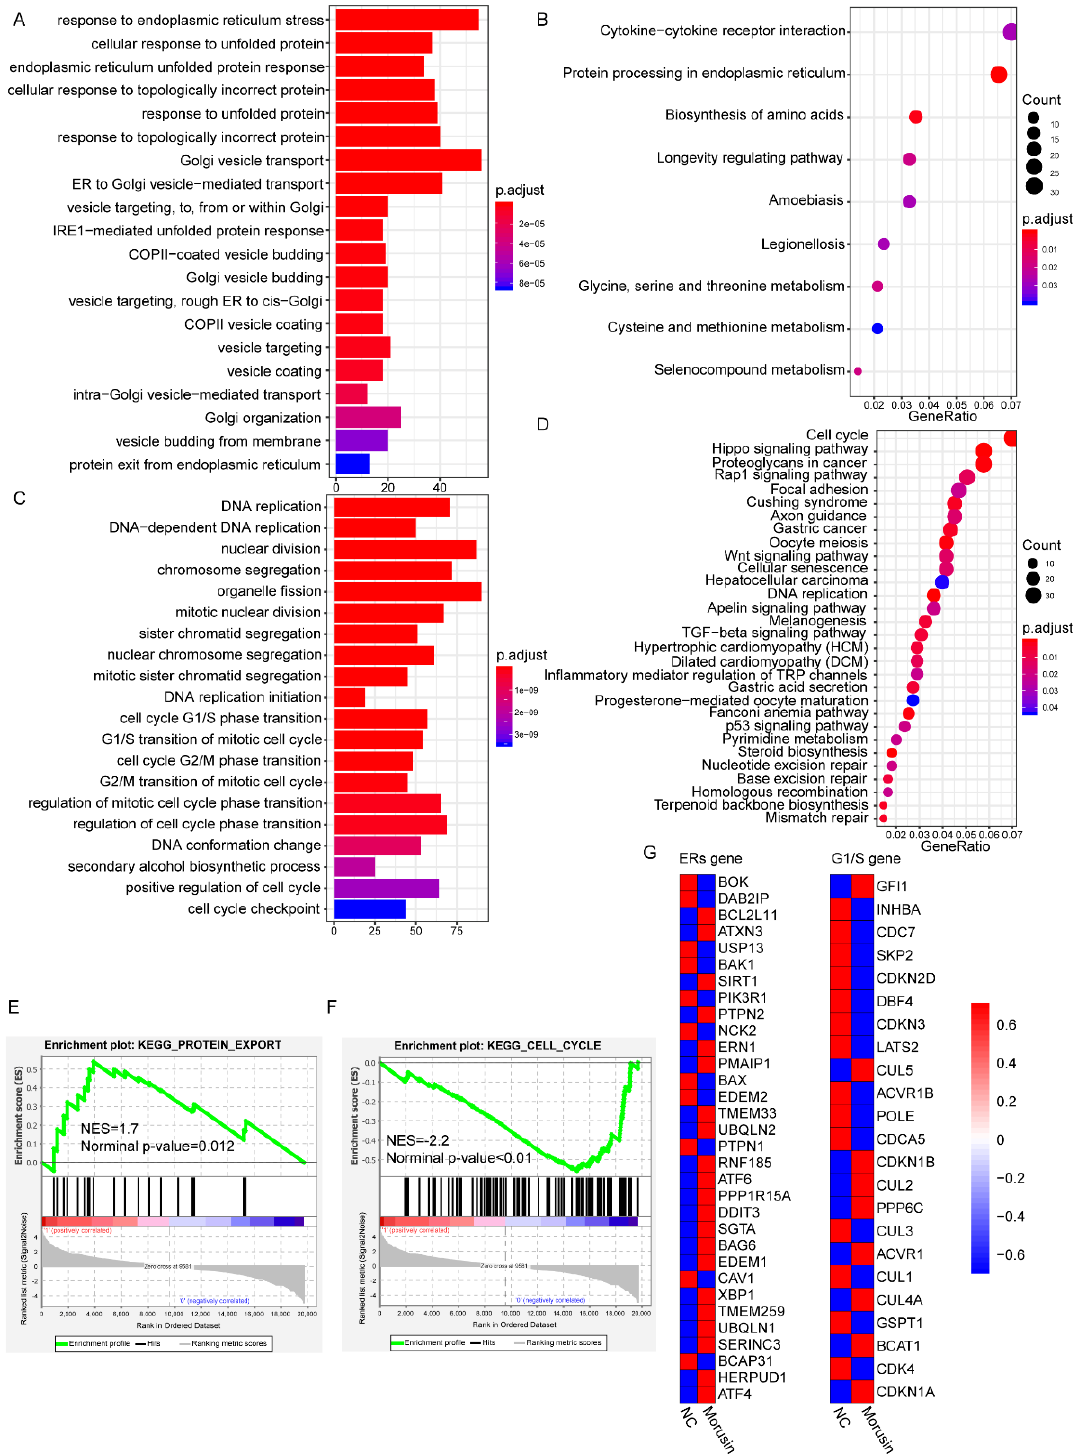
Figure 5. RNA-seq analysis of morusin treated U87 cells. ( A , B ) Gene Ontology (GO) and Kyoto Encyclopedia of Genes and Genomes (KEGG) pathway enrichment analysis of up-regulated mRNA after morusin treatment. ( C , D ) GO and KEGG pathway enrichment analysis of down-regulated mRNA. ( E , F ) GSEA-based KEGG enrichment plots of representative gene sets from activated pathway (protein export) and suppressed pathway (cell cycle). ( G ) Heatmap of mRNA expression levels in two KEGG gene sets (ERs and G1/S).